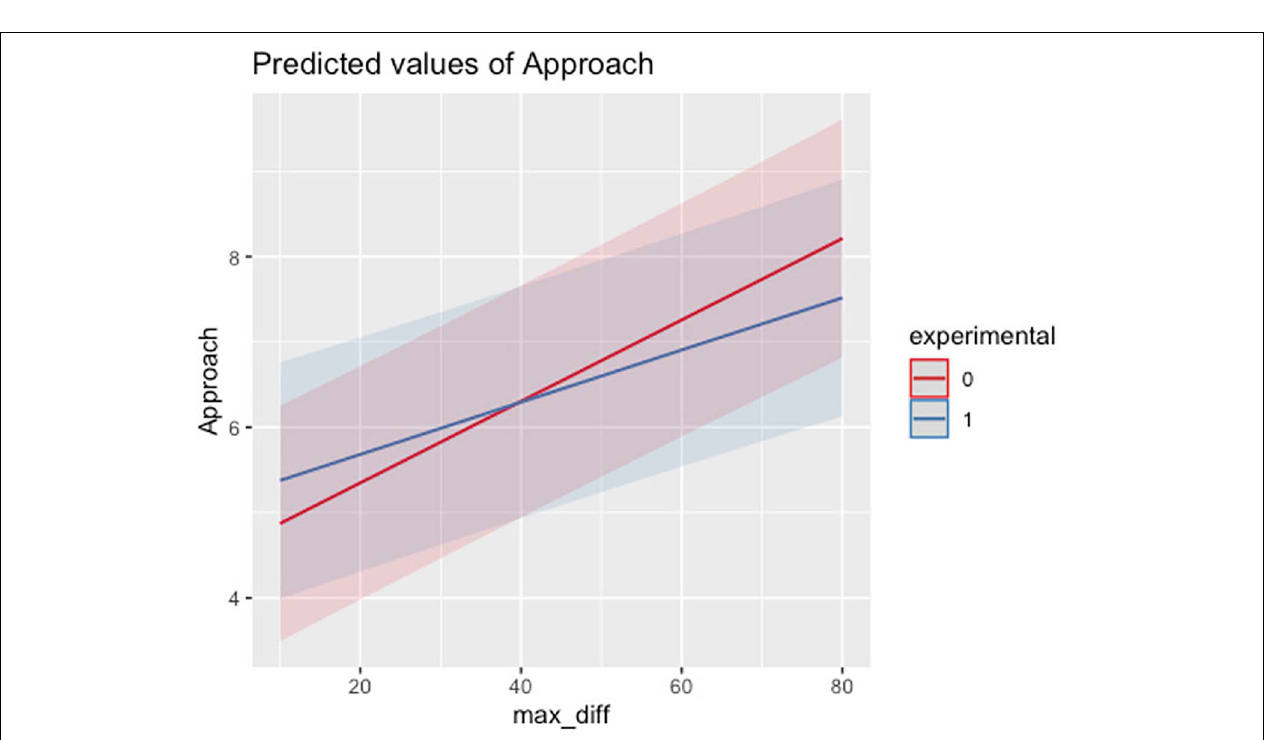
FIGURE 2 | Interaction effect for Approach Score and Maximization (decision difficulty